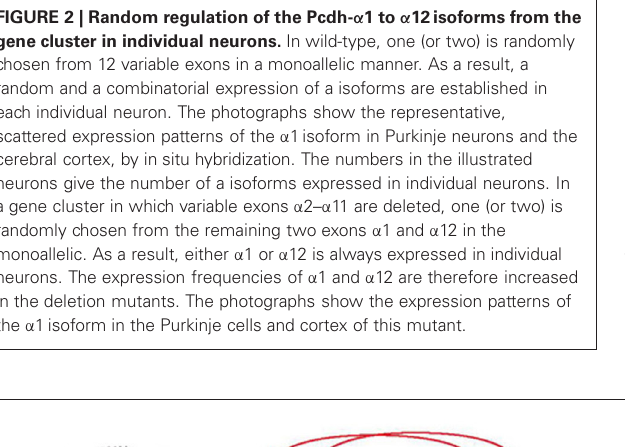
FIGURE 3 | Schematic diagram of the independent regulation of the Pcdh- α , β , and γ gene clusters by cis -regulatory elements. The HS5–1 element controls the expression of α 3– α C1 depending on the distance. The HS-7 element controls the whole Pcdh- α cluster. The cis -regulatory elements, called the cluster control region (CCR), control Pcdh- β and are